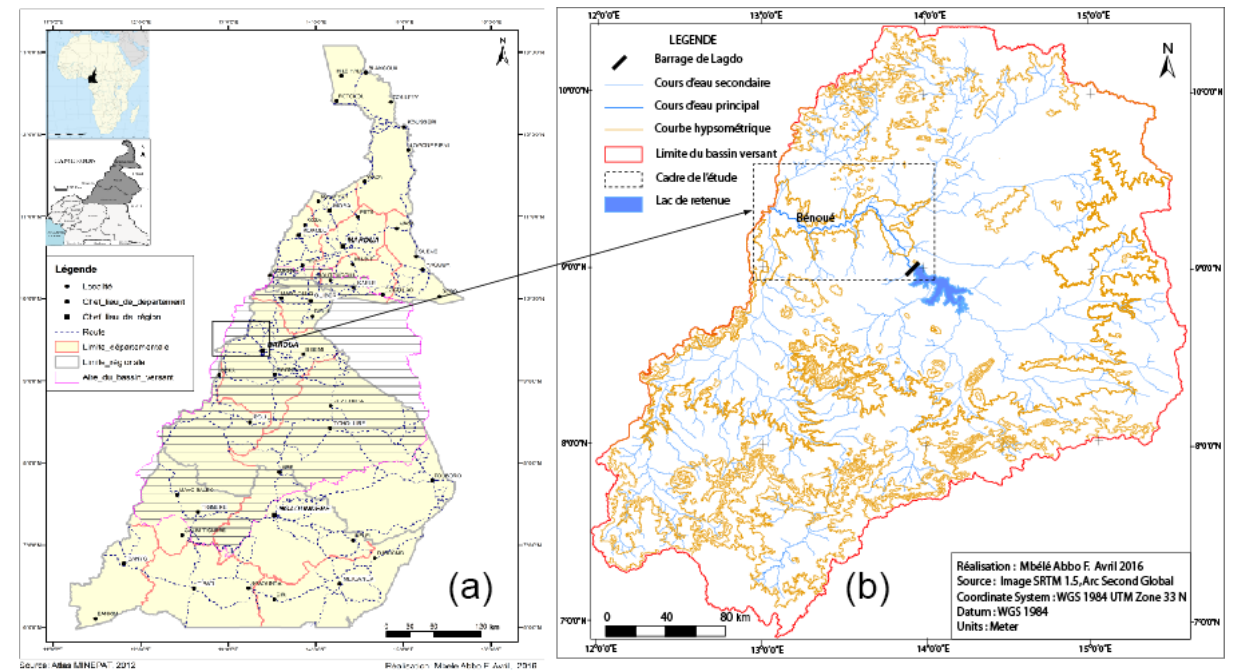
Figure 1. Localisation (a) et oro-hydrographie (b) du cadre de l’étude.